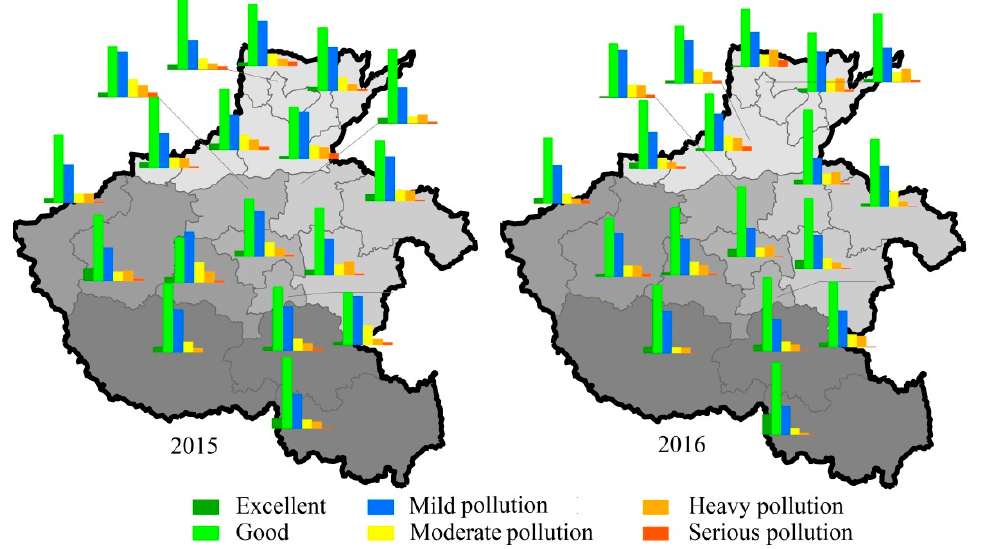
Figure 4. Proportions of days with different air quality levels at the city scale in 2015–2016. The grey color changes from light to deep denote north, east, center, west, and south Henan Province, respectively.